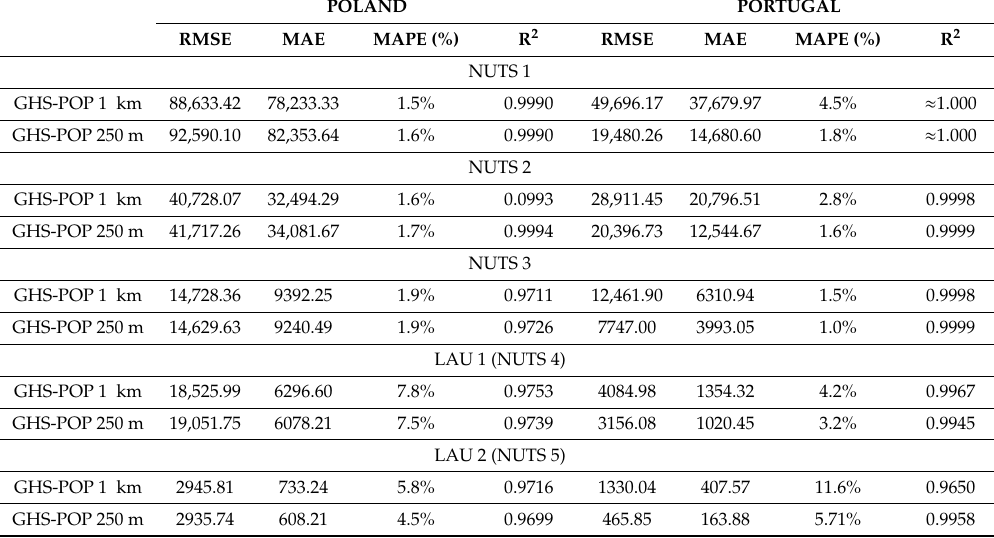
Table 3. Root mean square error (RMSE), mean absolute error (MAE), and mean absolute percentage error (MAPE) values for the GHS-POP 1 km and GHS-POP 250